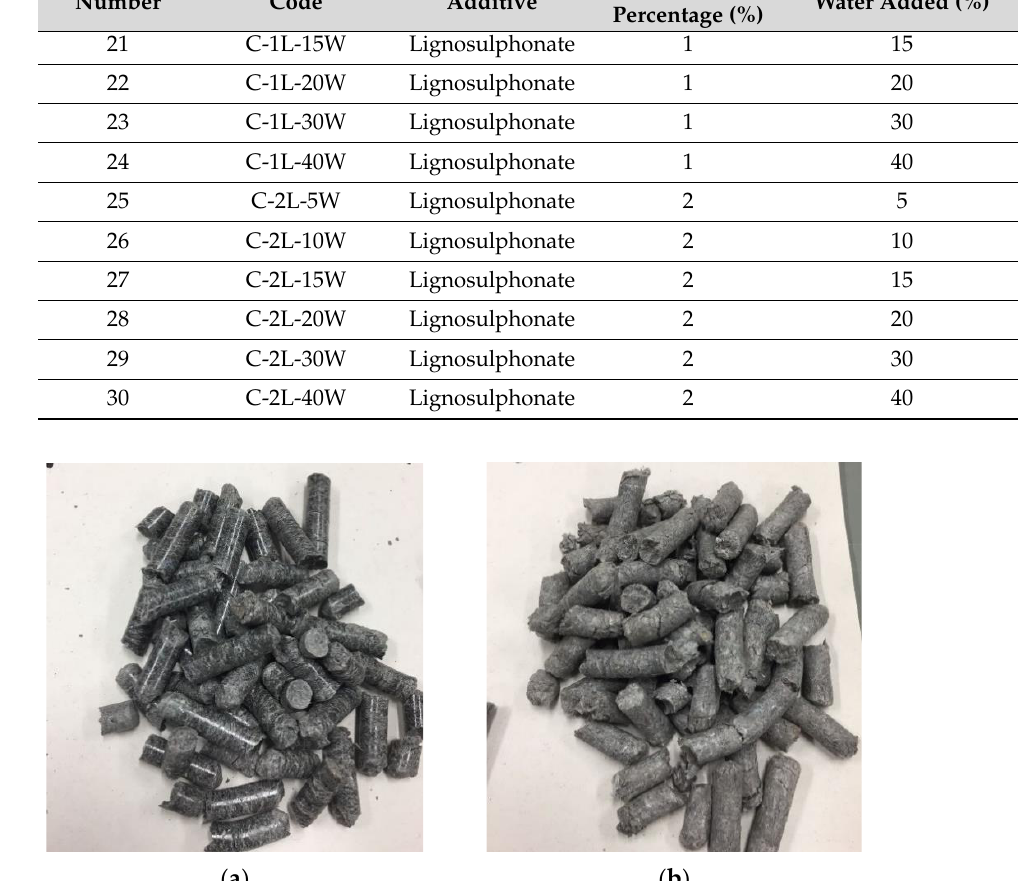
Figure 1. Pellets manufactured, ( a ) moisture content 10% and ( b ) moisture content 40%. Table 2. Laboratory investigation combinations.